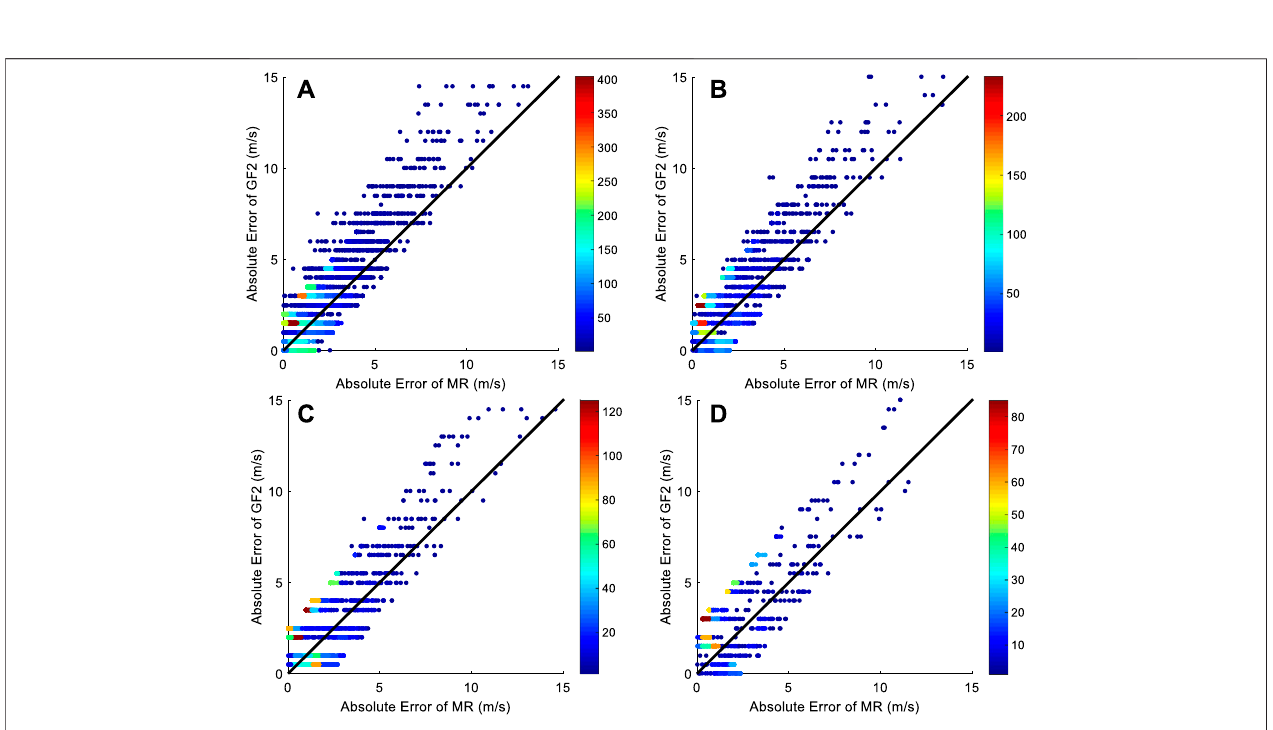
FIGURE 7 | The scatter diagrams of absolute errors ofthe multiple regression method (MR) and the wind gust factor method (GF2) for four different observed gust magnitudes: (A) 14 – 16 m/s, (B) 16 – 18 m/s, (C) 18 – 20 m/s, (D) 20 – 22 m/s. The color in the scatter in the fi gure indicates the number of repeated scatter points.